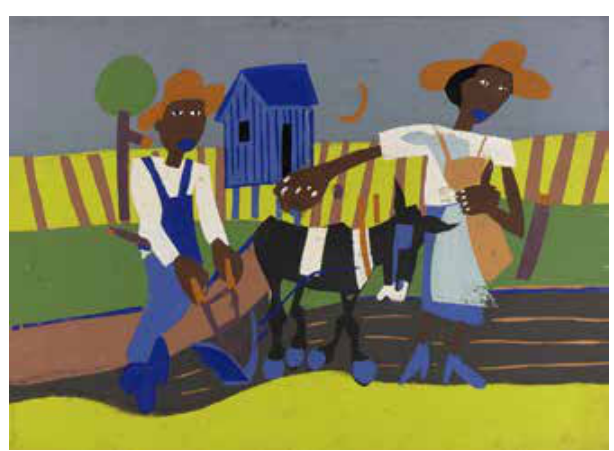
Figure 1: Human, animal and environmental health are intimately intertwined. Image credit: “Sowing” from Smithsonian Institution via VisualHunt / No known copyright